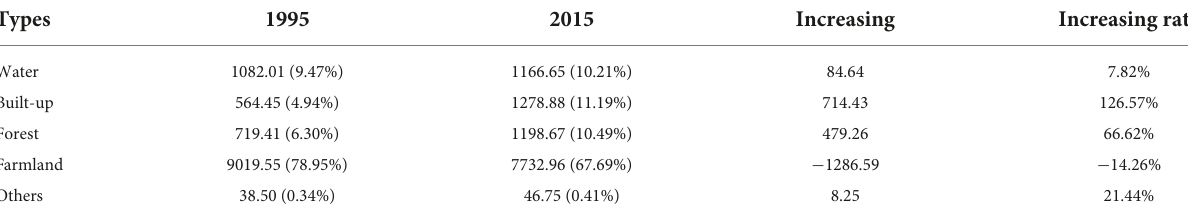
TABLE 2 Transfer matrix of green space during the period of 1995–2015 in Hefei city (unit: km 2